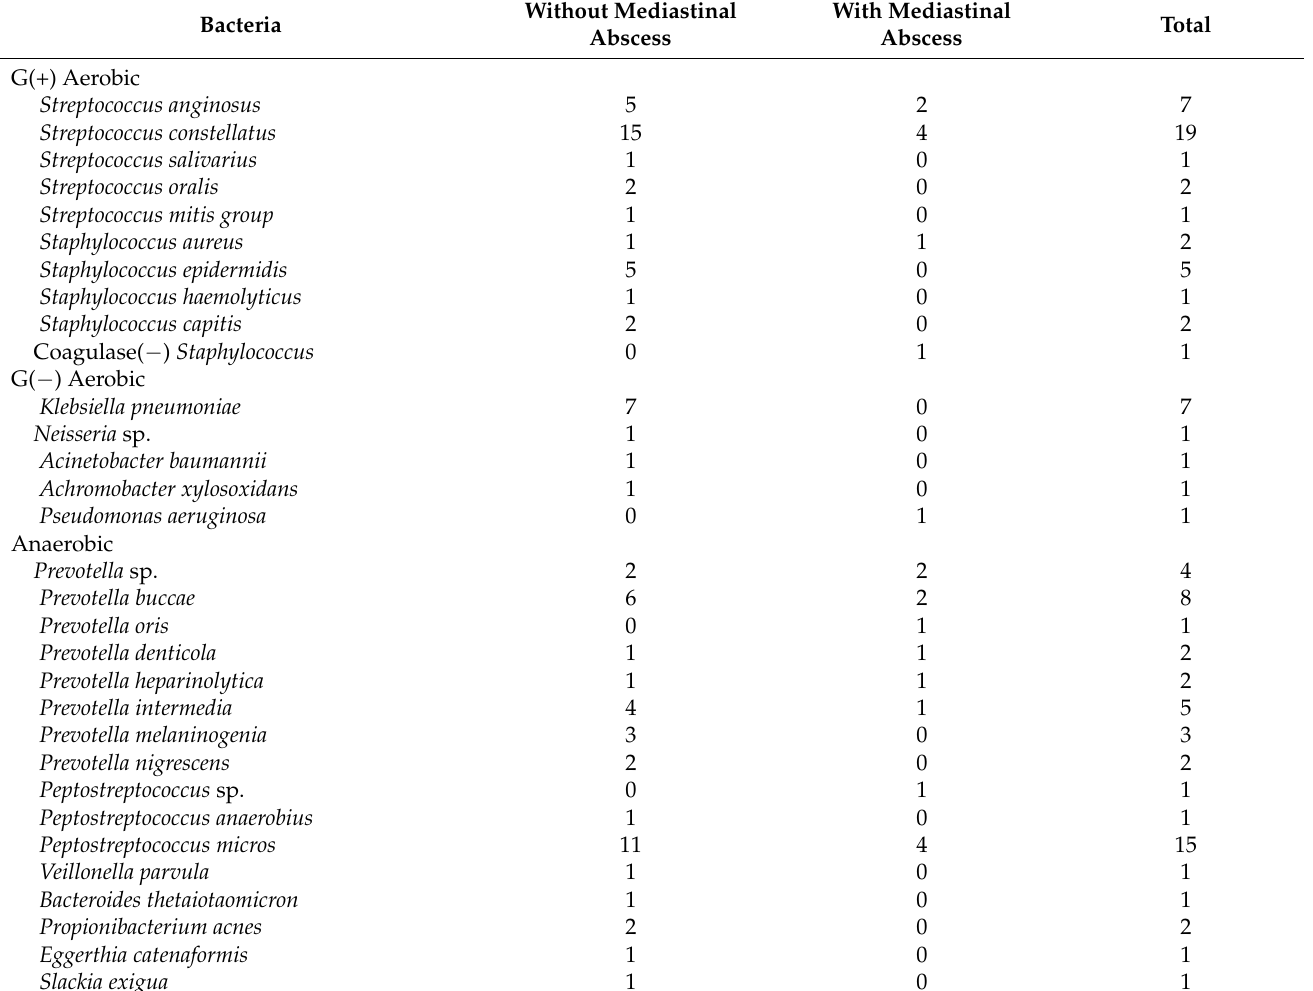
Table 3. Bacteria identified in the neck and mediastinal abscesses.